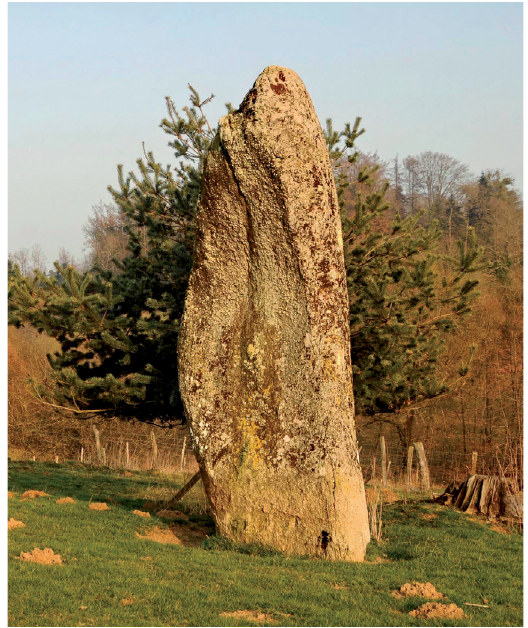
Figure 20. The Pierre Piquée menhir in Aubière (Puy-de- Dome). © G. Bonhomme.